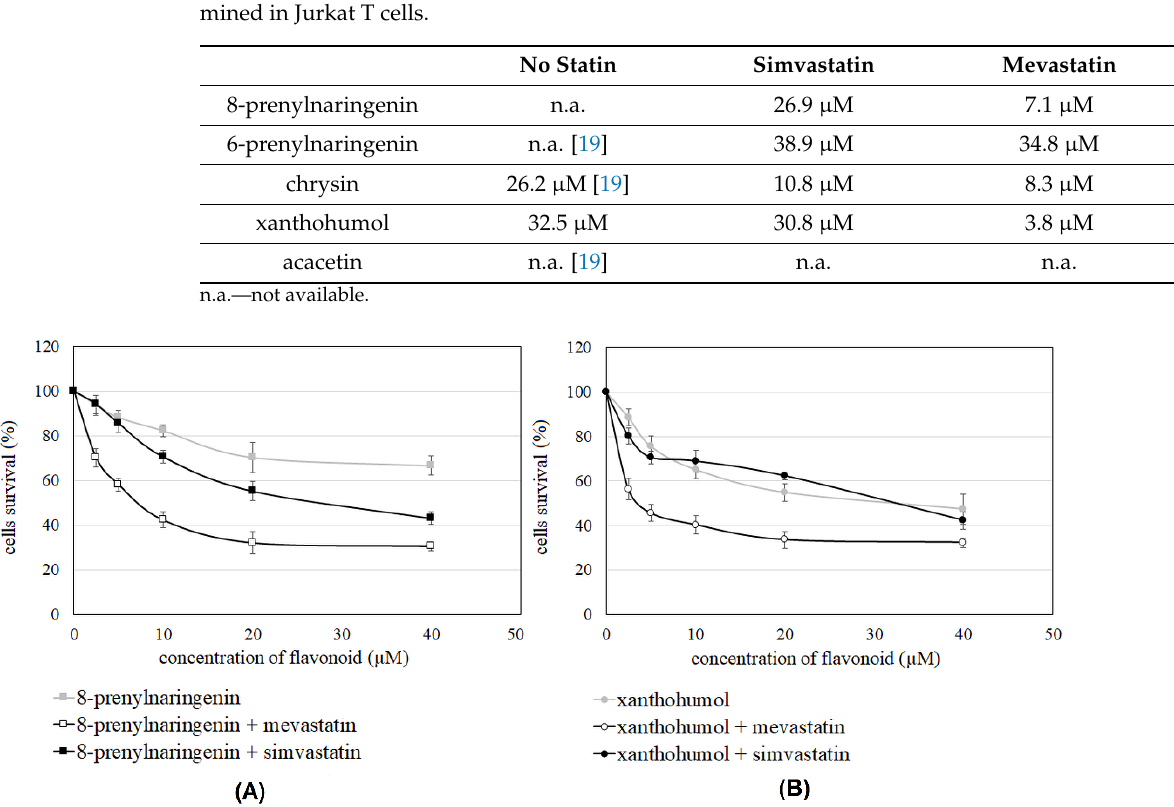
Figure 4. Representative profiles of growth inhibition for pure flavonoids 8-prenylnaringenin ( A ) or xanthohumol ( B ) and their combinations with simvastatin or